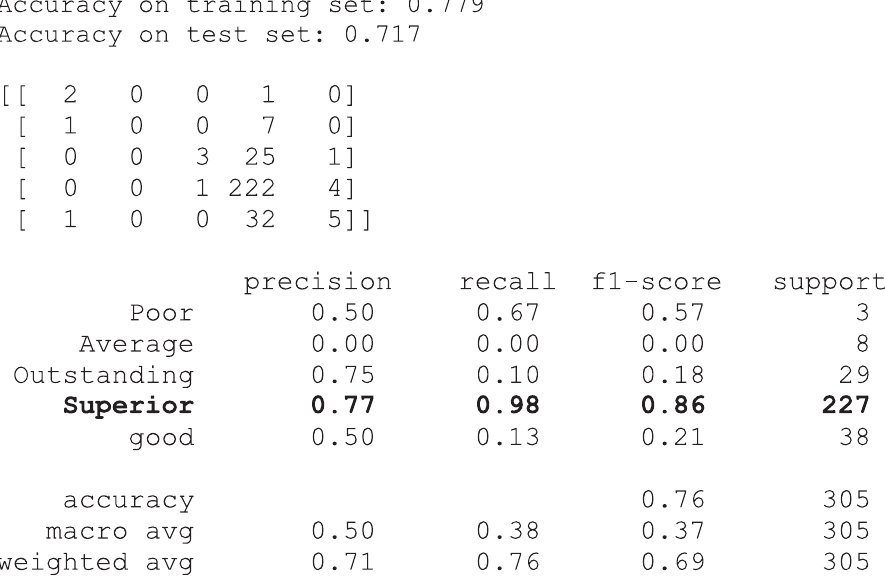
Figure 11: Decision tree confusion matrix and accuracy